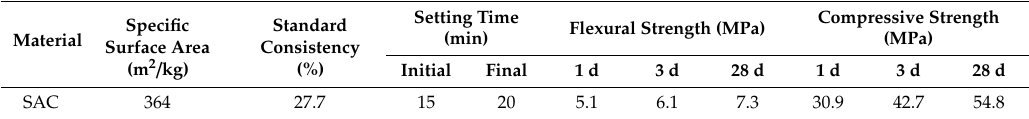
Table 1. Physical properties of sulfoaluminate cement (SAC).